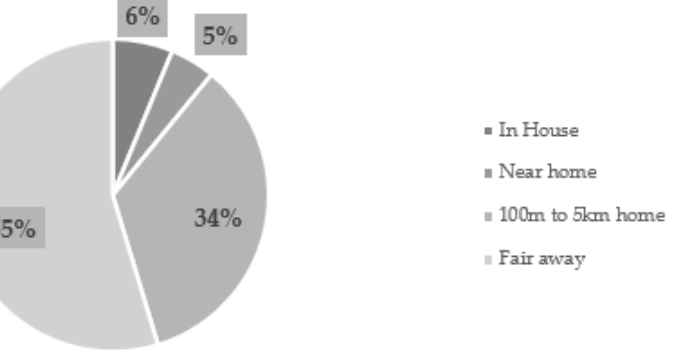
Figure 3. Relationship between the victims and the place of death-June 2017 [16].